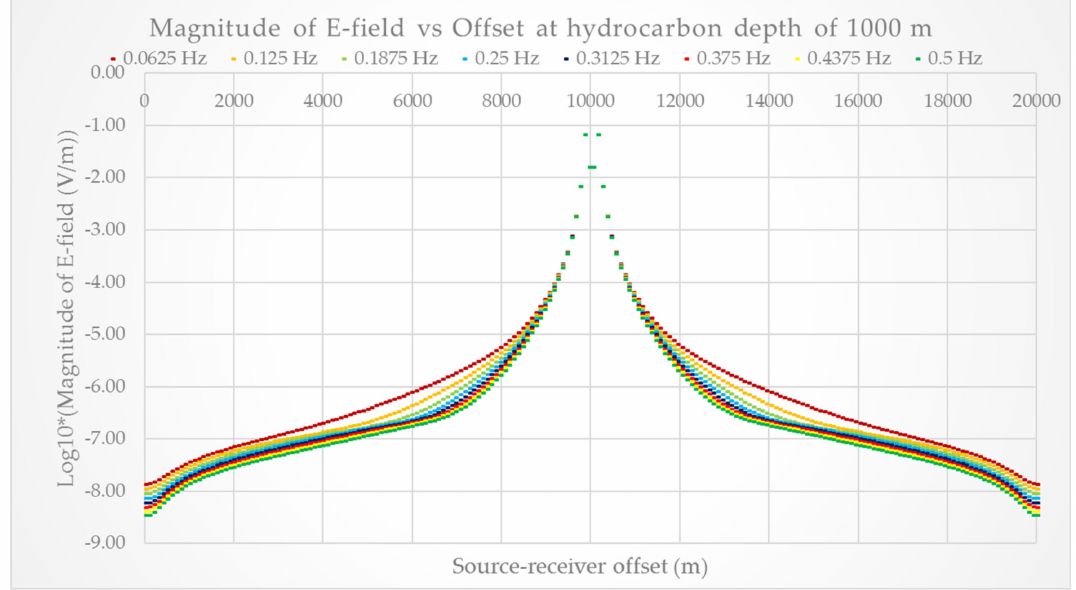
Figure 3. EM responses obtained from the target models, where the hydrocarbon layer was located at 1000 m from the seabed, for multiple frequencies (0.0625–0.5 Hz with an increment of 0.0625 Hz each). The total source-receiver separation distance is 20,000